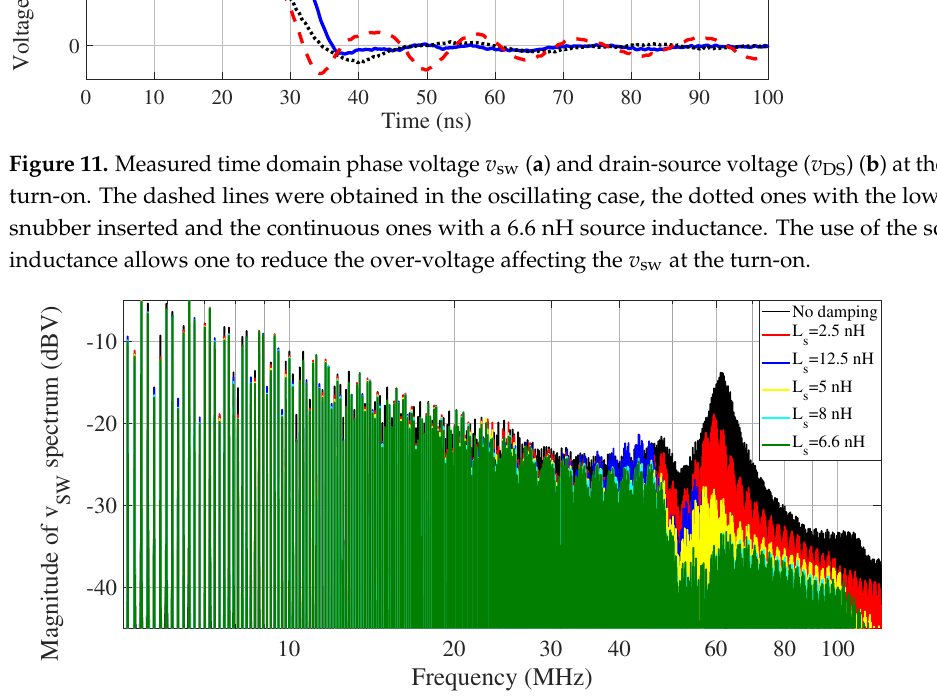
Figure 12. Frequency spectra of the measured switching voltage ( v sw ) with 3 A output current and different source